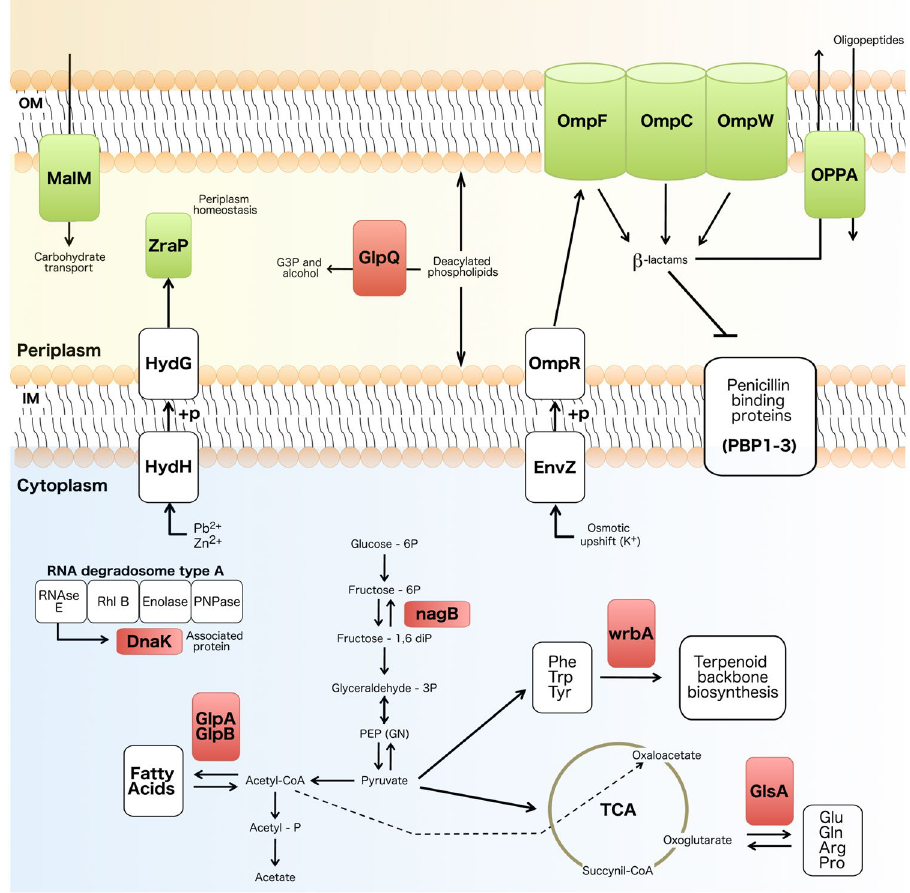
Figure 3. Schematic magainin I-resistant E. coli cell representation. Schematic representation of a magainin I-resistant cell, highlighting its differentially expressed proteins (green: upregulated; red: downregulated), as well as their biological pathways according to KEGG. Differentially expressed proteins observed in Table 1 and not represented here did not present biological pathways on KEGG. Abbreviations: OM: outer membrane; IM: inner membrane; OmpC, F and W: outer membrane proteins; MalM: maltose operon periplasmic protein; ZraP: zinc resistance-associated protein; GlpQ: glycerophosphoryl diester phosphodiesterase; GlpA and B: anaerobic glycerol-3-phosphate dehydrogenase subunit A and B, respectively; G3P: glycerol-3-phosphate; OppA: periplasmic oligopeptide-binding protein; HydH: sensor protein ZraS; HydG: transcriptional regulatory protein ZraR; OmpR: transcriptional regulatory protein OmpR; EnvZ: osmolarity sensor protein EnvZ; DnaK: chaperone protein DnaK; NagB: glucosamine-6-phosphate deaminase; WrbA: NAD(P)H dehydrogenase (quinone); glutaminase 1; Phe: phenylalanine; Tpr: tryptophan; Tyr: tyrosine; Glu: glutamic acid; Gln: glutamine; Arg: arginine; Pro: proline; TCA: tricarboxylic acid